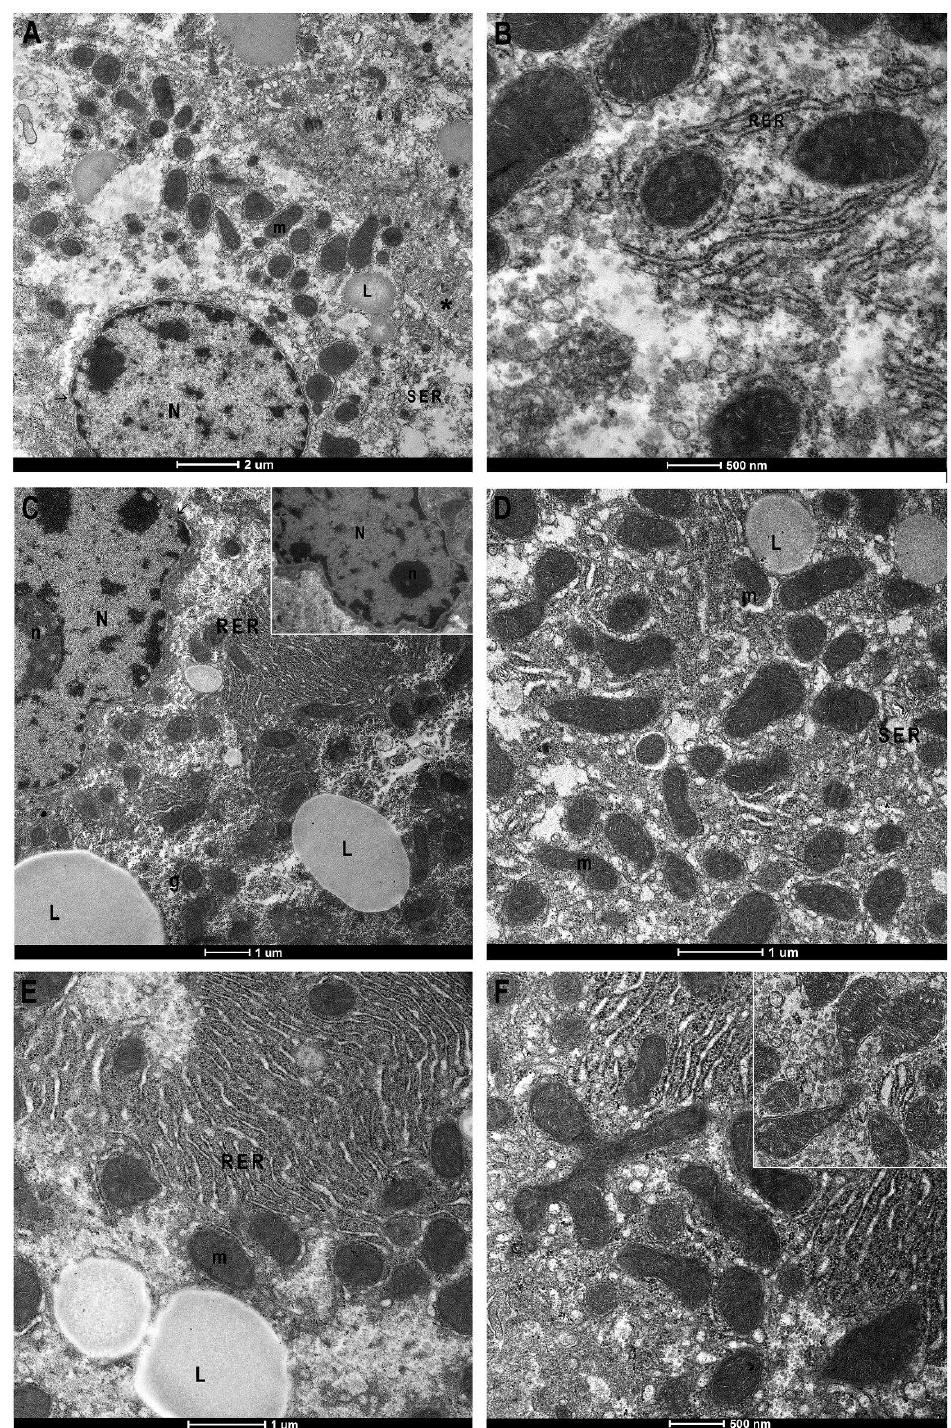
Figure 4. Transmission Electron Microscopy micrographs of control and BTBR mice liver. Control (CTR) ( A , B ) and BTBR mice liver ( C – F ). CTR liver shows regular nucleus (N), few lipids drop (L), well-preserved mitochondria (m) associated with rough (RER) or smooth reticulum (SER) ( A ). Greater magnification of mitochondria, surrounded by RER ( B ). BTBR liver shows irregular nuclear envelope, hypertrophic nucleoli and RER with congested cisterns, increased number and size of lipid drops ( C ). Mitochondria, mostly small in size ( C – E ) and mitochondrial fission phenomena (( F ) and insert) are recognizable. Asterisk: bile canaliculus; (g) glycogen; (arrow) nuclear pore. Magnification: ( A ) 2550 × , ( B ) 9900 × ( C ) 4000 × , ( D ) 7800 × , ( E ) 7000 × , ( F ) 9900 ×